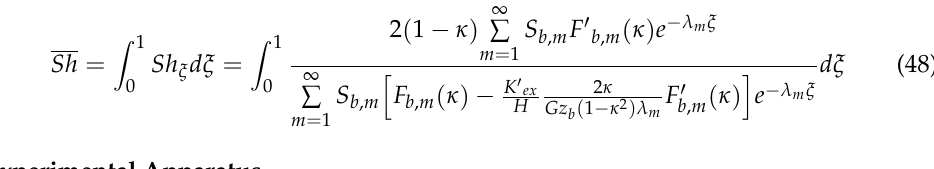
Figure 3. A photo of an experimental setup (MEA (red); CO 2 (blue)). The inner concentric ring tube was made of stainless-steel wire matrix (No. 3016) with 1.5 cm inside diameter shown in Figure 4a, which was formed with perforated holes of 1.26 mm × 1.26 mm square to allow gas to diffuse through. A hydrophobic membrane PTFE/PP was wound around the circumference of the surface of the circular wire matrix ring tube, and routed with a 0.2 mm nylon fiber on the membrane surface on the outside of the inner tube shown in Figure 4c. The empty lumen channel in concentric circular membrane contactor tube is constructed by using an effective 0.2 m long concentric tubu- lar acrylic tube of outer diameter 3.0 cm shown in Figure 4d. A gas mixture containing CO 2 /N 2 from the gas mixing tank, and the MEA solution from a reservoir in thermostat (G-50, 60L, 3500W, DENG YNG, New Taipei, Taiwan) were selected as the feed gas and the absorbent solution, respectively. The various operation conditions of flow rate for liq- uid absorption with various flow rates (5.0, 6.67, 8.33, and 10.0 cm 3 /s) into the lumen chan- nel were regulated by a flow meter (MB15GH-4-1, Fong-Jei, New Taipei, Taiwan), while keeping a gas stream containing CO 2 /N 2 from the gas mixing tank (EW-06065-02, Cole